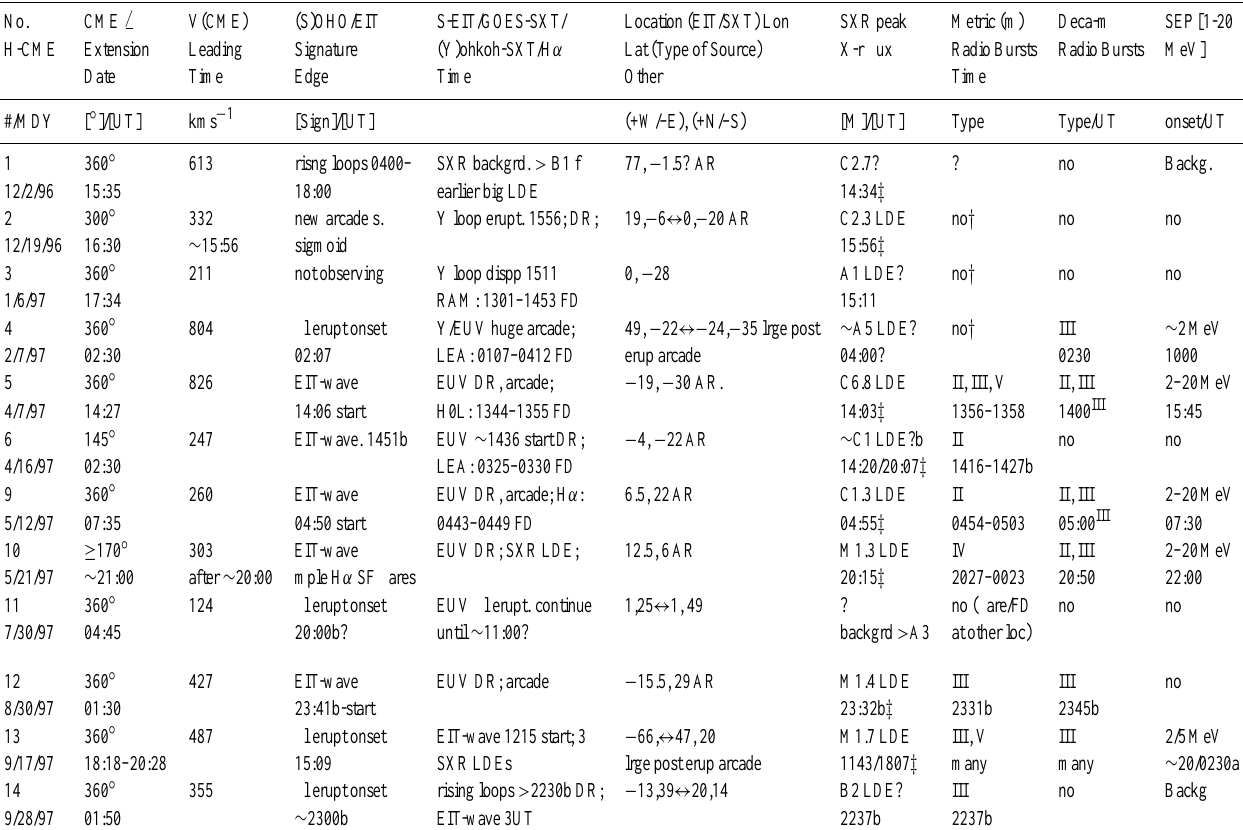
Table 2. Solar and low corona signatures